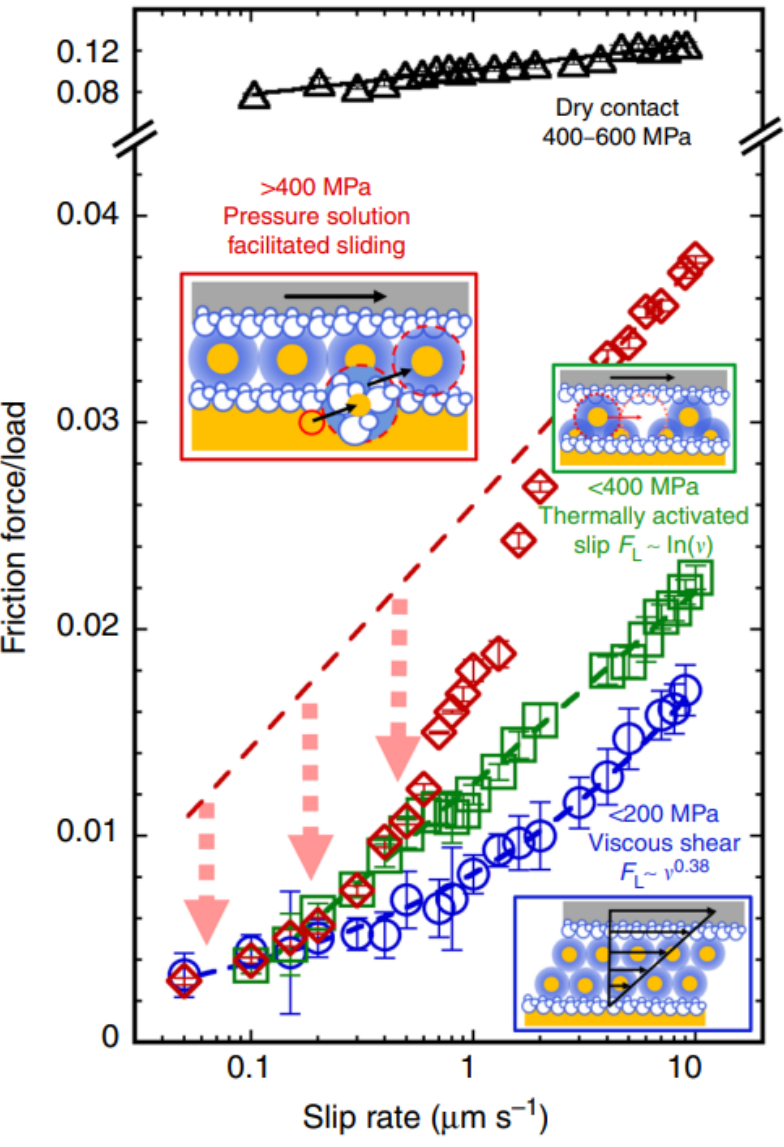
solution (after 2